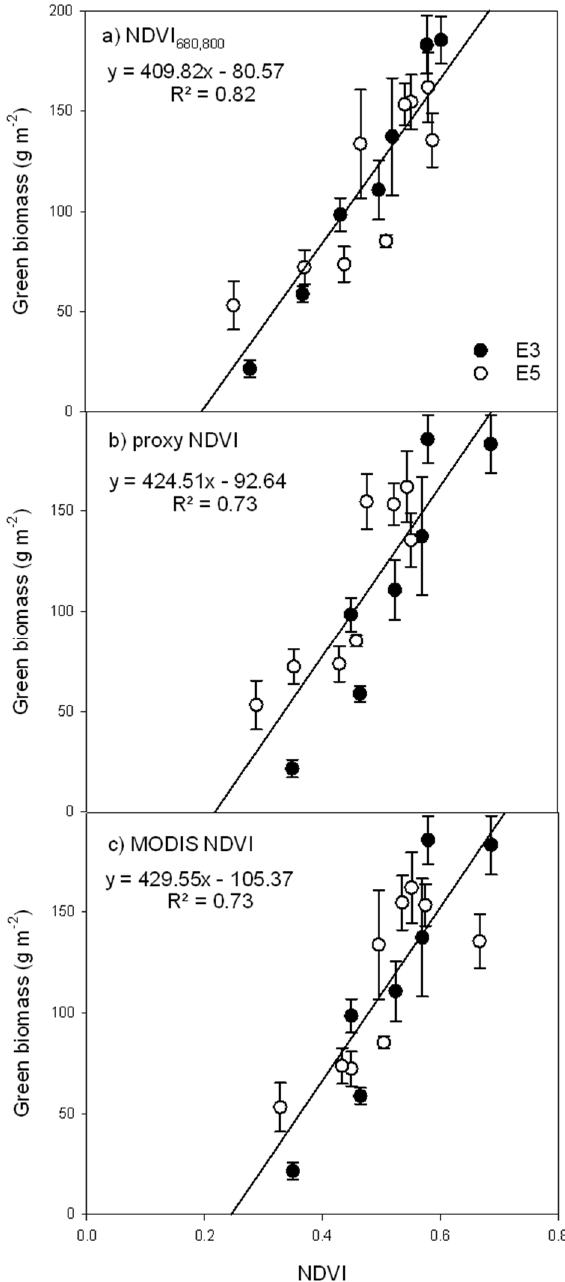
Figure 6. Correlations between green biomass and ( a ) NDVI 680,800 ; ( b ) proxy NDVI (5 h averaged) and ( c ) MODIS NDVI for both E3 (black dots) and E5 sites (white dots) in 2012 and 2013. Error bars for green biomass are expressed as standard error of the mean. Resulting equations and correlations ( R 2 values) are indicated for each fit